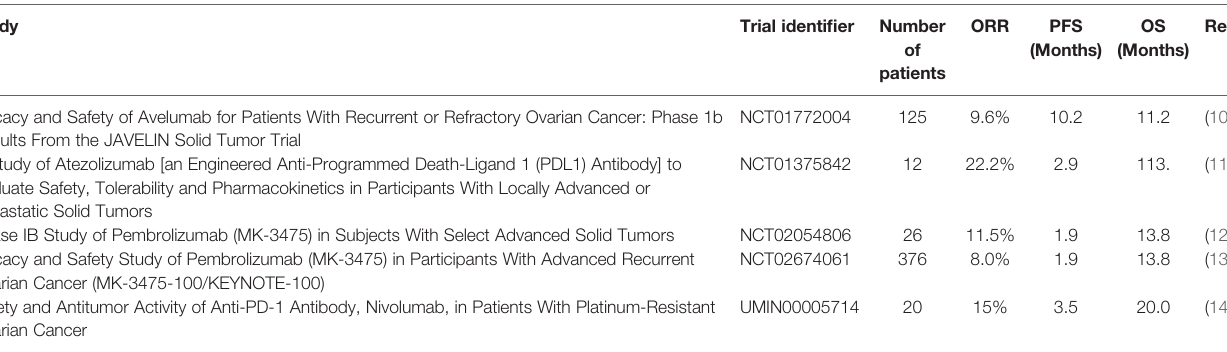
TABLE 1 | Results from trials exploring ef fi cacy and safety of single-agent ICIs in OC.